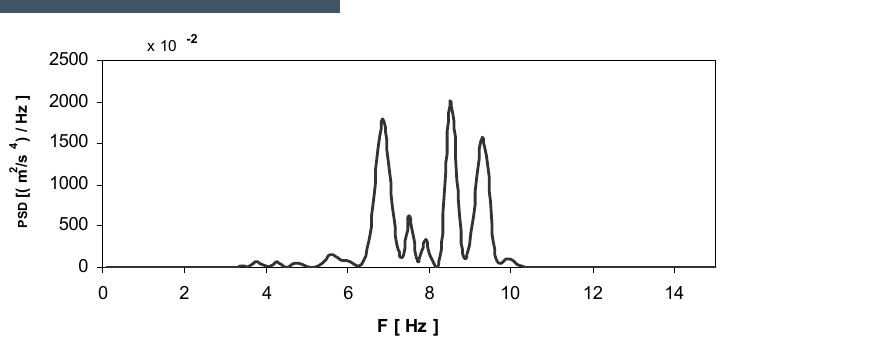
Fig. 6. PSD of road surface excitations.